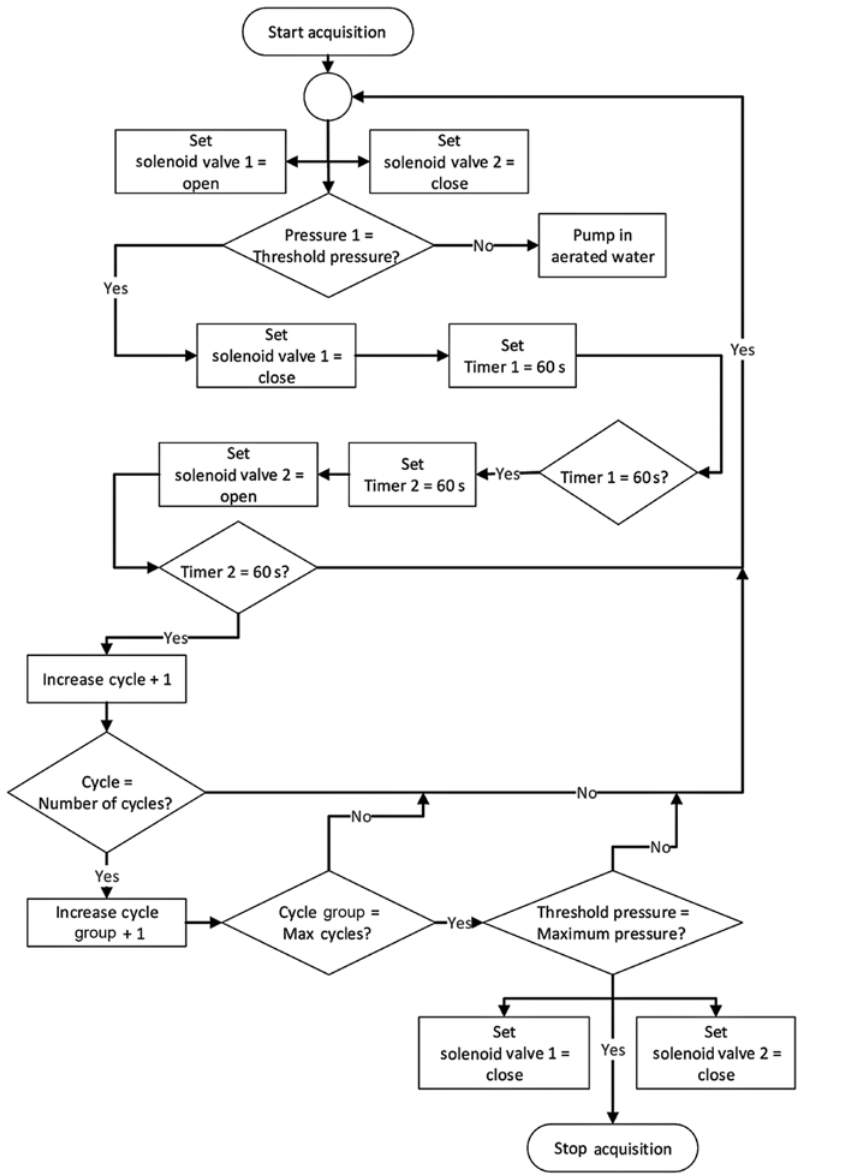
Figure 8: Protocol for ultimate elastic wall stress (UEWS) cyclic loading test.